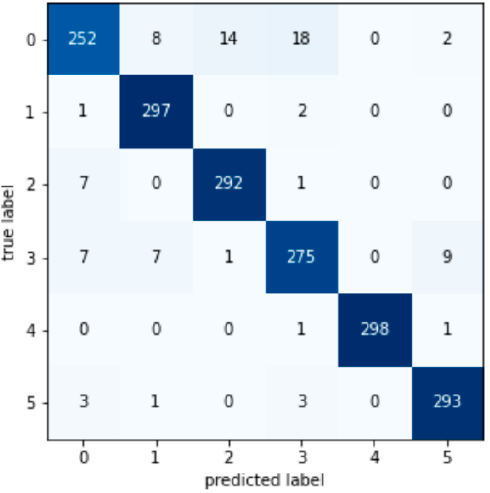
Figure A5. Adaboost confusion matrix.